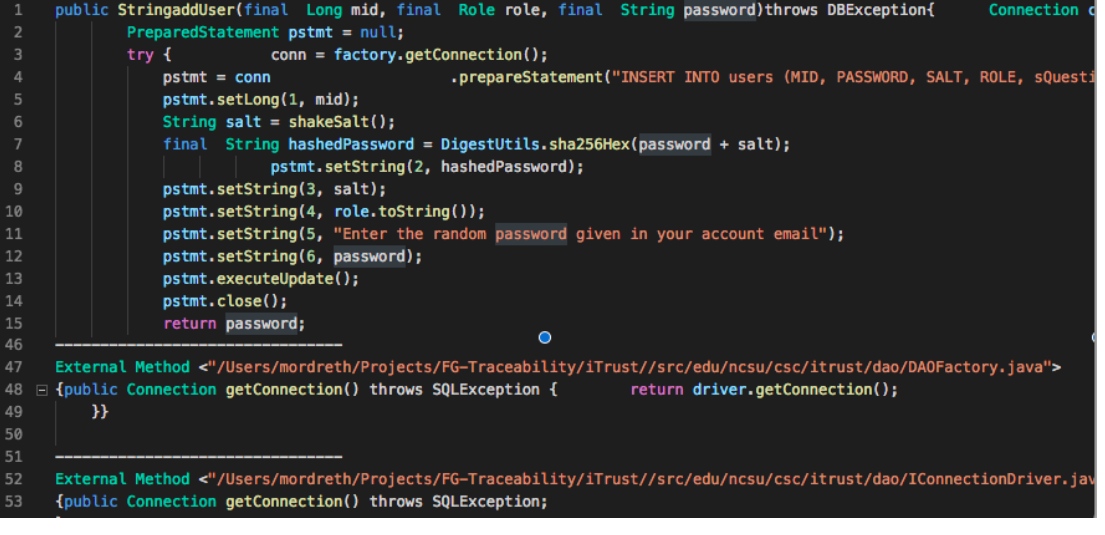
Figure 8: Example of the content for a particular result file. The source code slices and method calls are all included in the